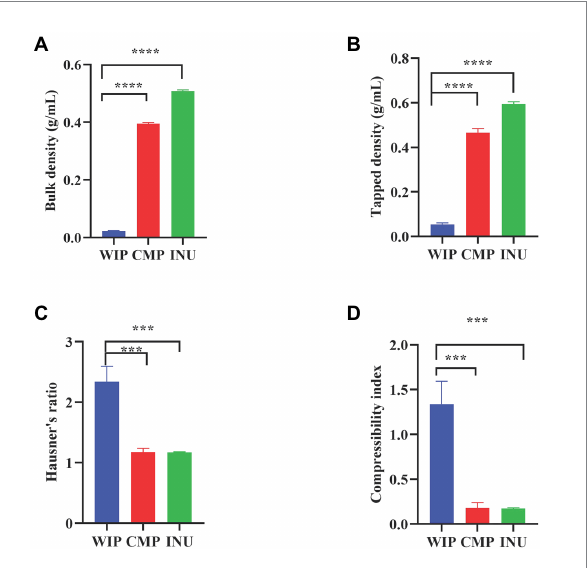
FIGURE 6 Density characteristics of WIP. (A) Bulk density, (B) Tapped density, (C) Hausner’s ratio and (D) compressibility index of WIP, CMP, and INU. *** p < 0.001 and **** p < 0.0001.